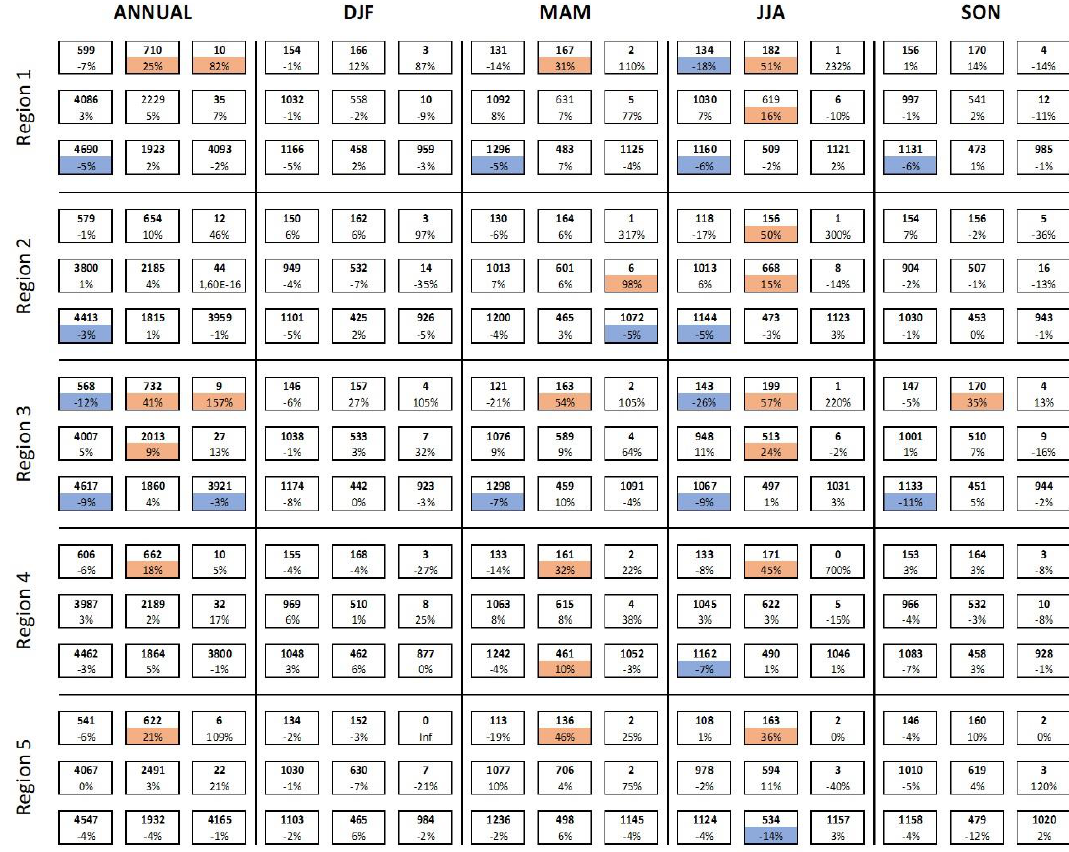
Figure 22. The number of events of helicity between 0 and 3 km for each type of event, region and season. For the historical climate (1st line of the cell) and the difference between the future and historical (2nd line of the cell). Shaded values indicate significant differences (t-student 5%) positive (red) and negative (blue).